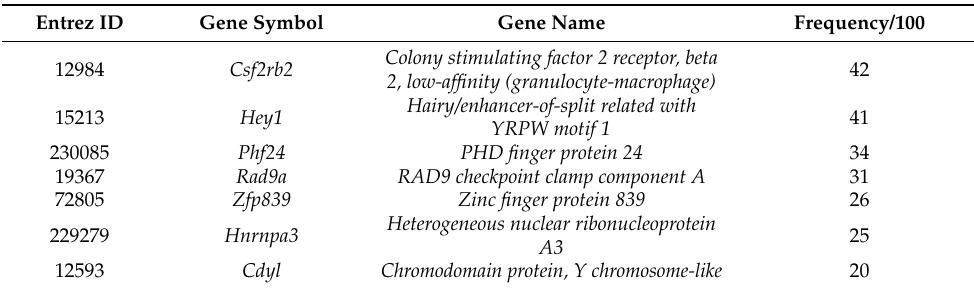
Table 6. The most frequent genes within 100 runs of the iterative feature selection procedure on the dataset without co-expressed.